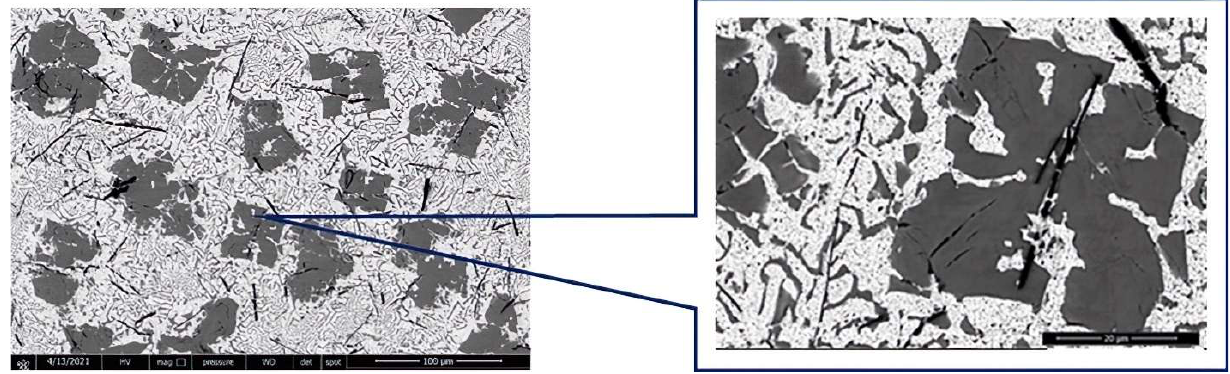
Figure 1. SEM image of YP1 sample at 100 µm and 20µm.